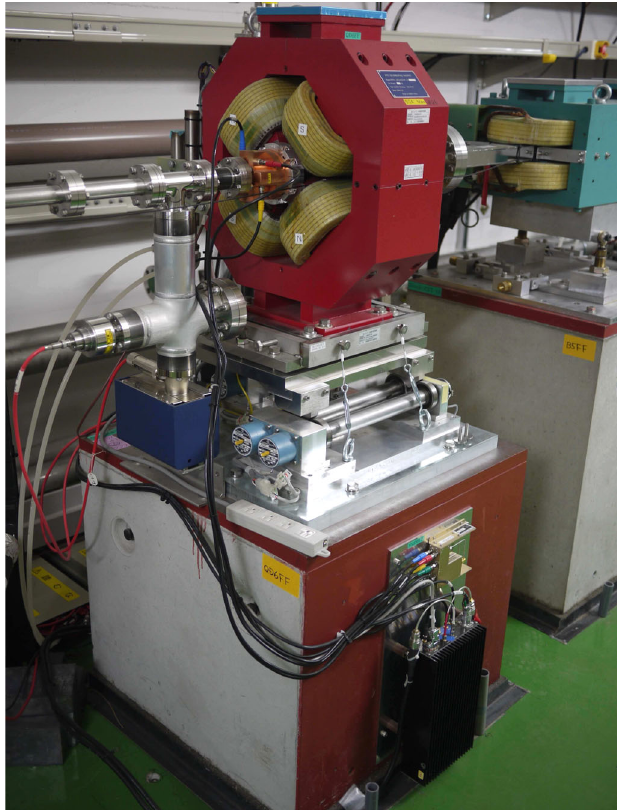
FIG. 8. Quadrupole magnet (QD6FF) and C -band CBPM as- sembly on a ATF2 mover. The rf processing electronics is mounted at the bottom of the concrete girder.